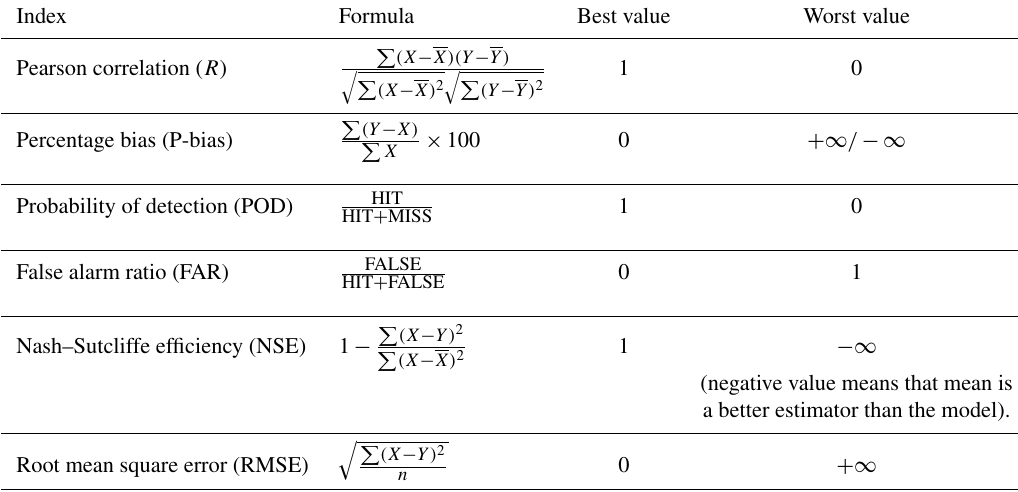
Table 3. Summary of different statistical indices used to evaluate the satellite precipitation products.